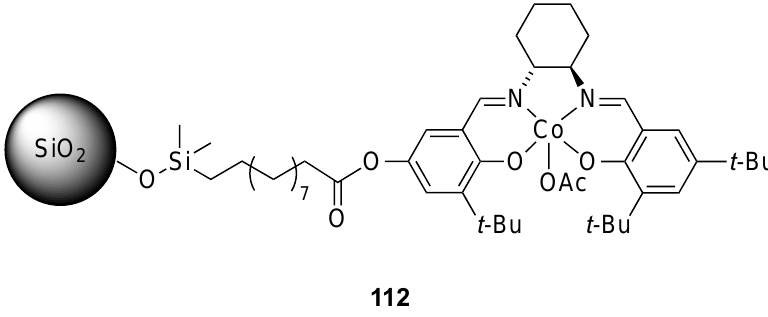
Figure 44. Silica-supported catalyst 112 .